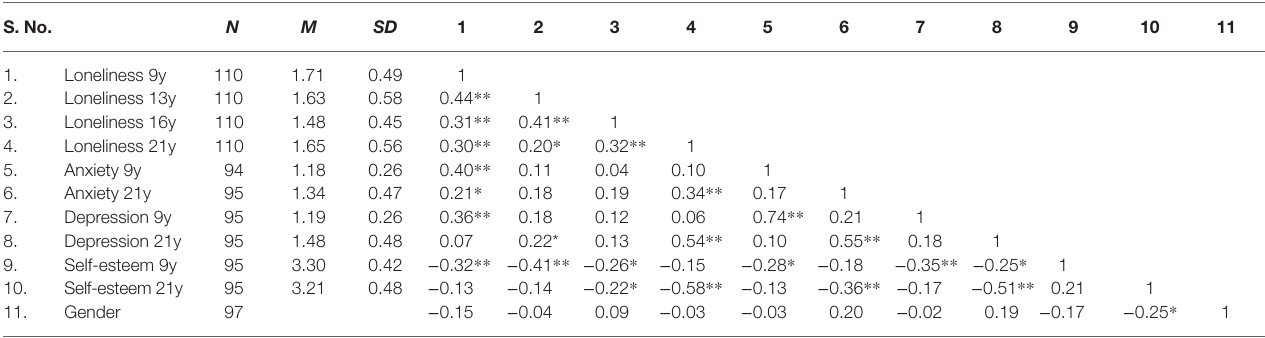
TABLE 1 | Descriptive statistics and correlations of loneliness and psychosocial functioning at different measurement waves. S.